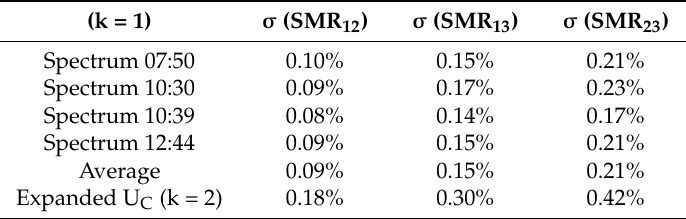
Table 2. Variations associated with all the input uncertainties using a Monte Carlo approach compared with the squared sum of all the contributions. The “±” sign is omitted for clarity.